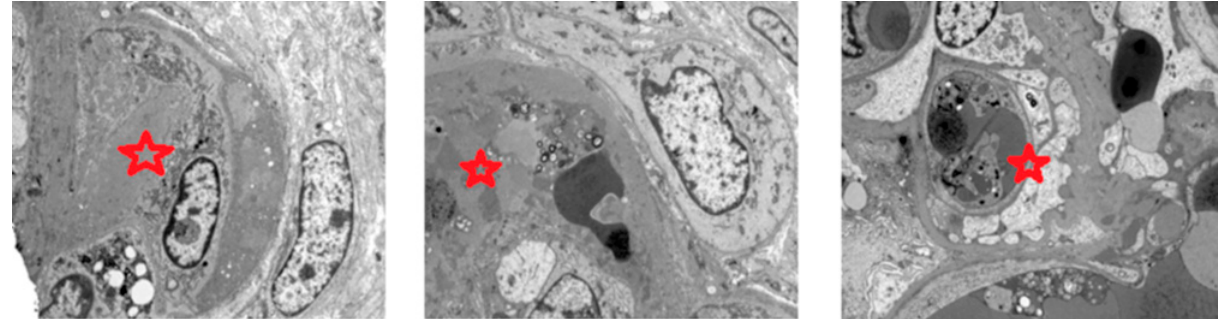
Figure 4. Electron microscopy. Fibro ‐ cellular thrombi (red stars) inside the arterioles.